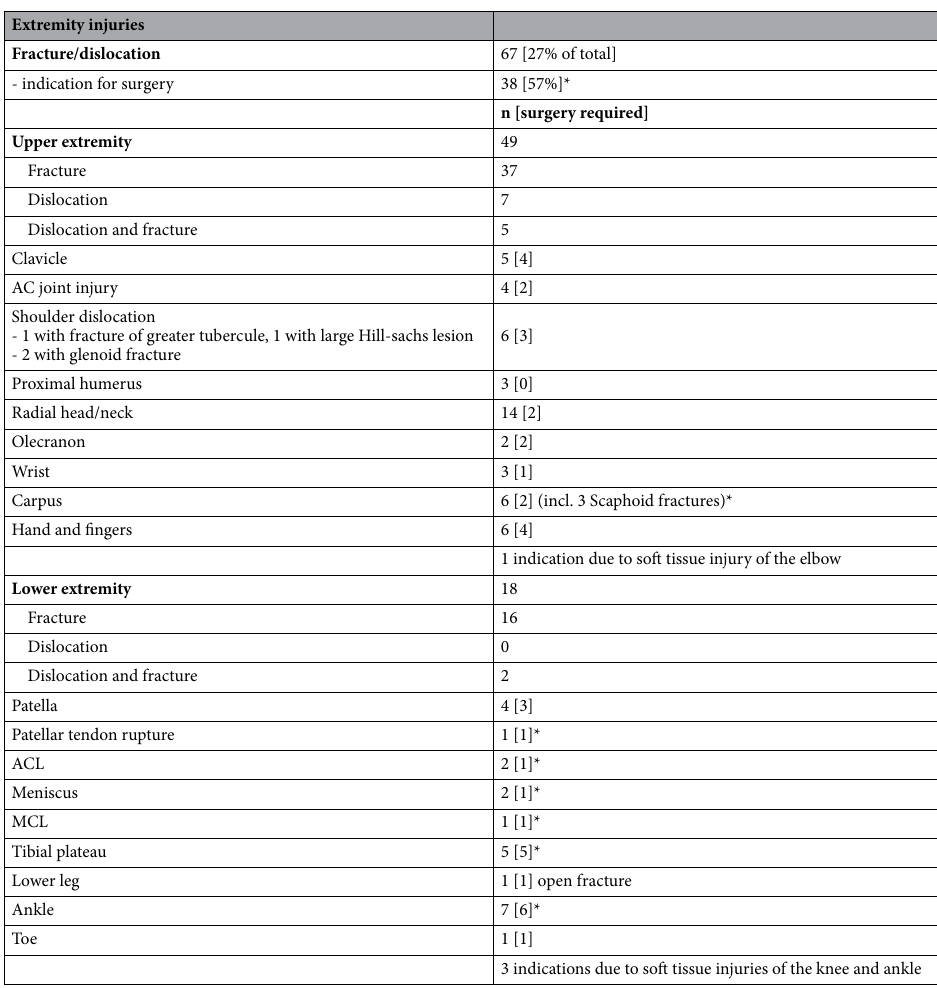
Table 3. Serious Injuries of the extremities sustained by e-scooter riders. *total number of cases that required surgery is lower than overall indications due to two patients who had surgically addressed injuries of the upper and lower extremity and two patients with complex knee injuries with bone and soft tissue